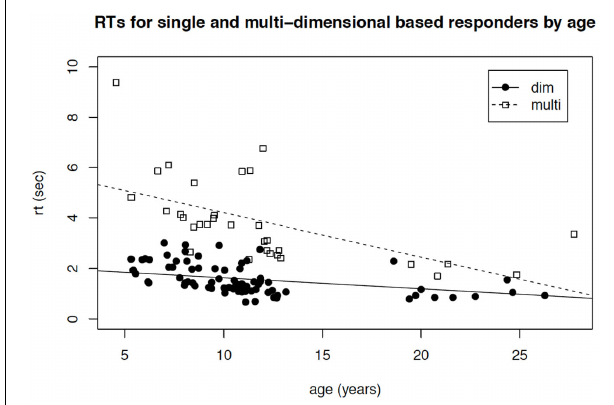
FIGURE 4 | Response times of one-dimensional (dim) responders and multi-dimensional (multi) responders, as a function of age of